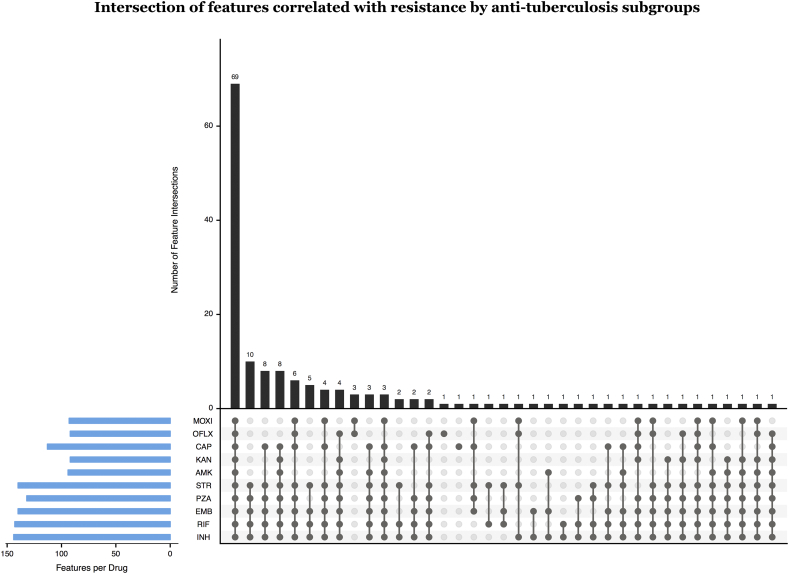
Intersection of predictors correlated with resistance by anti-tuberculosis drug subgroups. We permuted the resistance labels and calculated the distribution of the difference, P(isolate is resistant | mutation is present) – P(isolate is resistant | mutation is absent). We show the number of mutations per subgroup of drugs ordered from most to least mutations per subgroup. Number of significant predictors per drug is also shown.